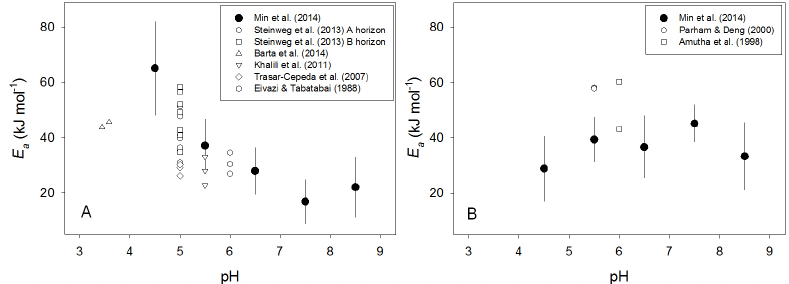
Figure 1. Estimates of intrinsic (closed symbols) and apparent (open symbols) E a for the BGase/BG reaction (a) and the NAGase/NAG reaction (b) . The literature values for apparent E a are shown at the pH at which the reaction was actually observed, and does not necessarily correspond to the pH of the soils from which the samples were taken. See Sect. 3 for